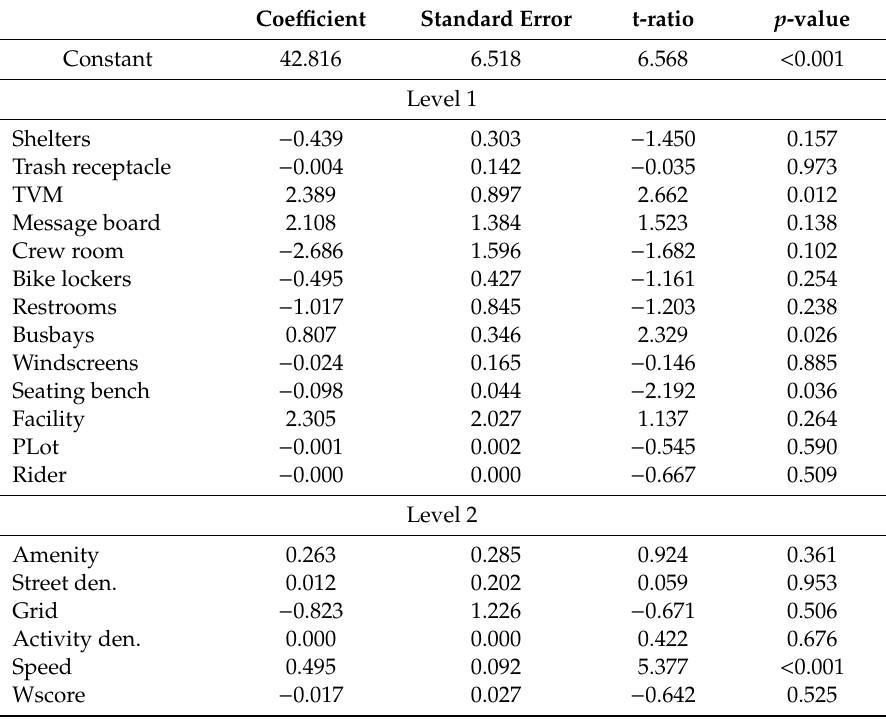
Table 5. Hierarchical linear modeling of log odds of sound levels in non-TOD